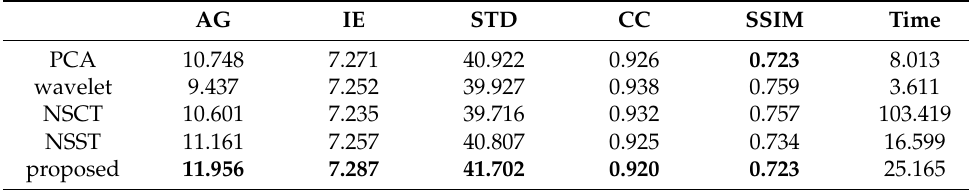
Table 2. Evaluation indexes of the fused images in scene